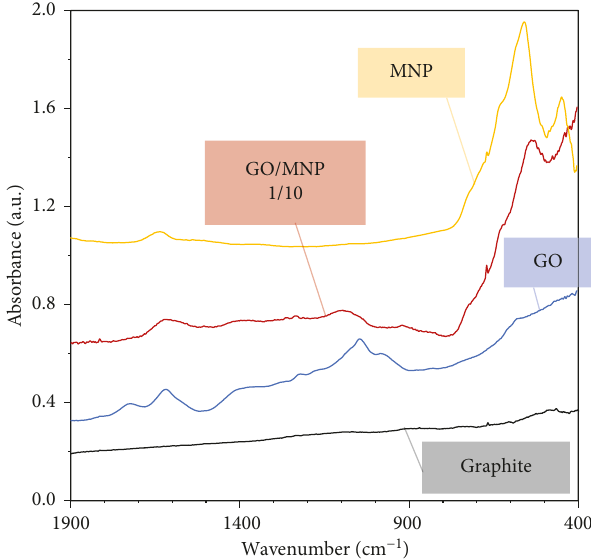
Figure 3: ATR-FTIR spectra of graphite, graphite oxide, bare MNP, and the GO/MNP nanocomposite at 1/10 mass ratio. The spectra are offset along the y -axis for